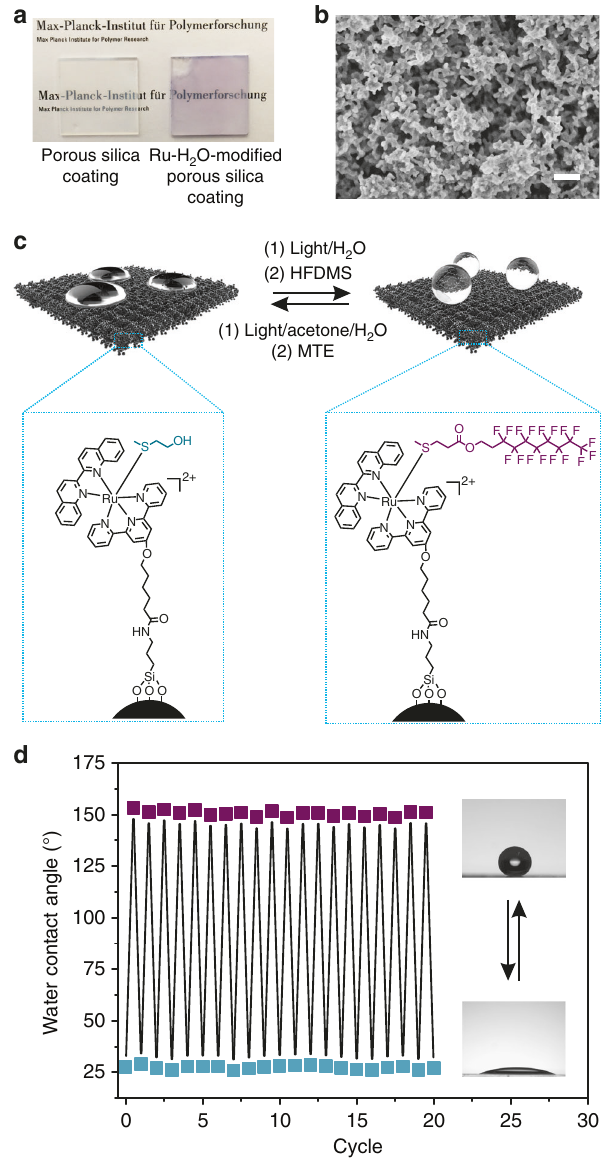
Fig. 6 Visible-light-controlled reversible switching of the surface wettability. a Photographs of the porous silica coating before and after modi fi cation with Ru-H 2 O. b Scanning electron microscope (SEM) image of the Ru-H 2 O- modi fi ed porous silica coating. Scale bar is 400 nm. c Schematic illustration of the reversible hydrophilic-to-superhydrophobic transitions based on visible-light-controlled metal – ligand coordination. d Change in the static contact angles when the ligands on the surface were interconverted between MTE and HFDMS. Blue squares indicate MTE ligands on the surface. Purple squares indicate HFDMS ligands on the